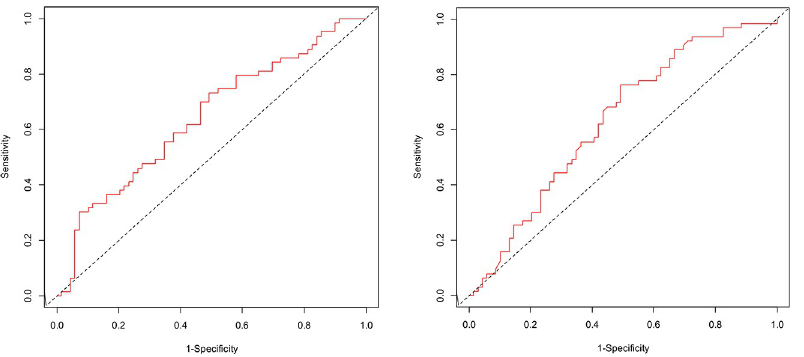
Fig 1. Receiver Operating Characteristic (ROC) curve for prediction of EOC death at 5-years in cohort 1. The left figure shows the ROC curve for prediction of EOC death by preoperative plasma HE4 levels (AUC = 64.2; 95% CI: 54.7–73.6). The right figure shows the ROC curve for prediction of EOC by preoperative plasma CA125 levels (AUC = 63.1; 95% CI: